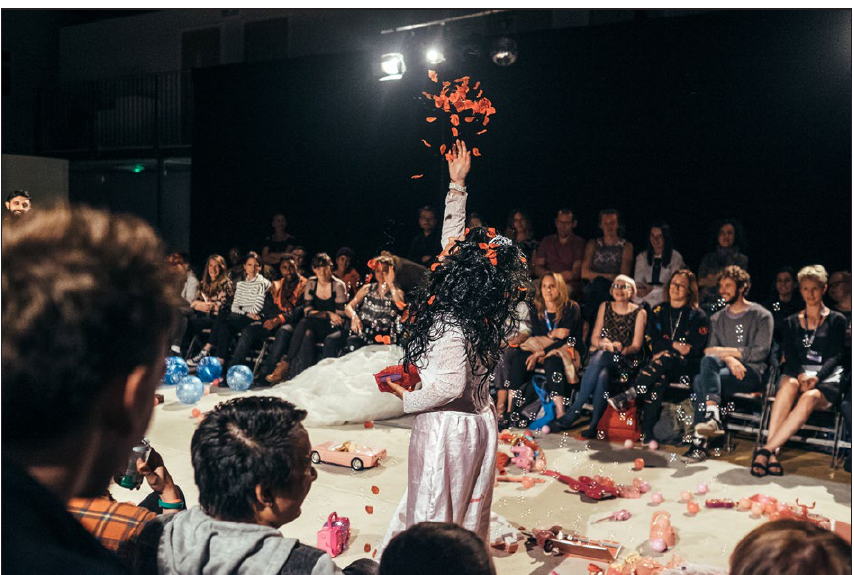
Figure 14: Jodie Hawkes, My Son and Heir, digital photograph, 2015.